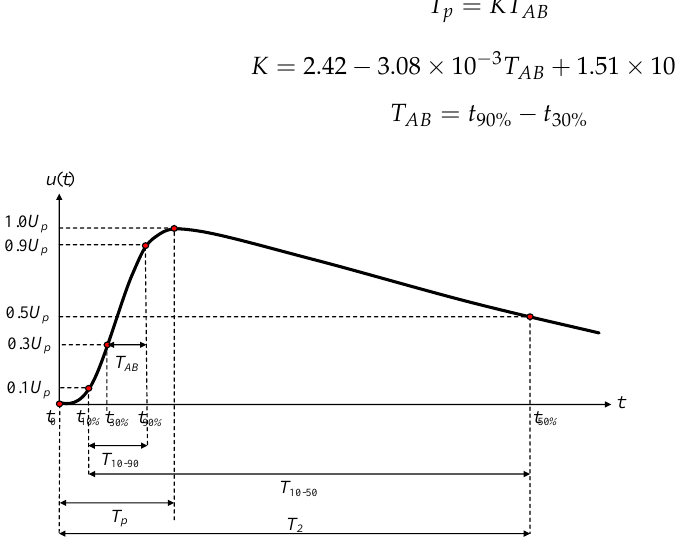
Figure 1. Switching impulse voltage waveform and the waveform parameters.